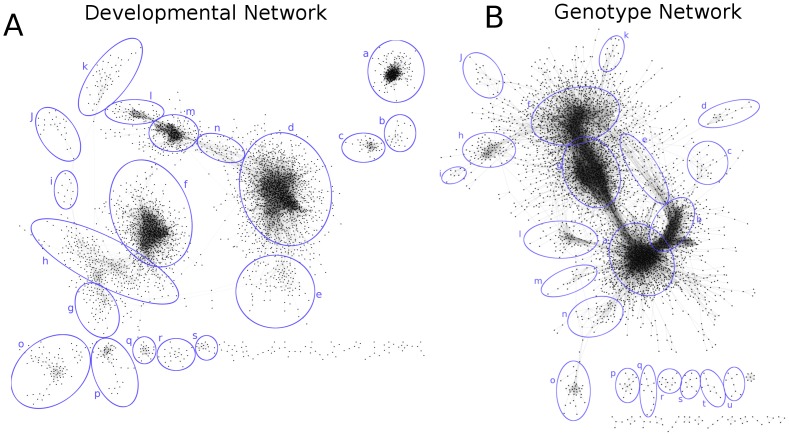
Clustering of co-expression networks.The strongest 100,000 interactions in each network were extracted and node positions were calculated using a force-directed algorithm which simulates interactions as springs while iteratively pushing nodes outwards. Highly connected nodes form natural clusters (circled in blue) in two dimensional space and are grouped based on their connectedness which is easily interpreted visually. The graph clustering algorithm, MCL, was also applied to the interactions. The resulting clusters overlapped with the global-scale clusters from the force-directed layout (Tables S3 and S4 in File S1).